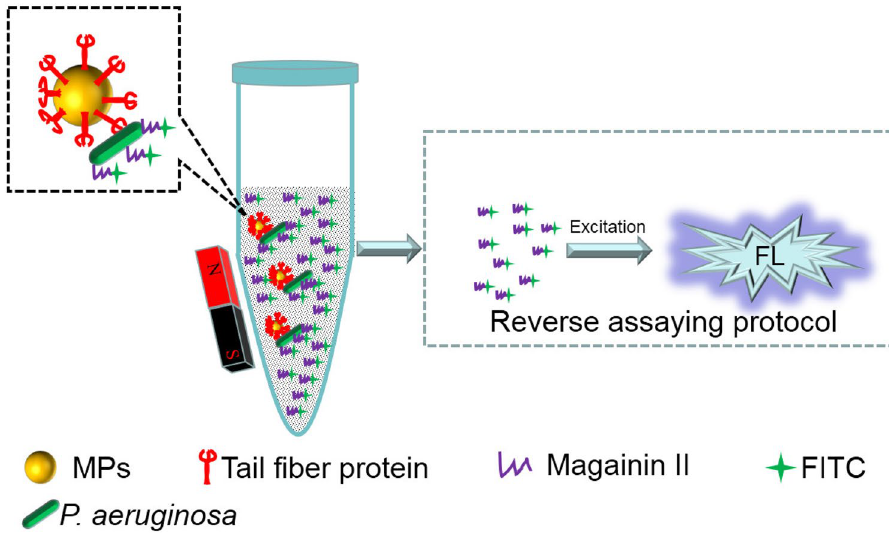
Figure 1. Schematic illustration of RAP for P. aeruginosa